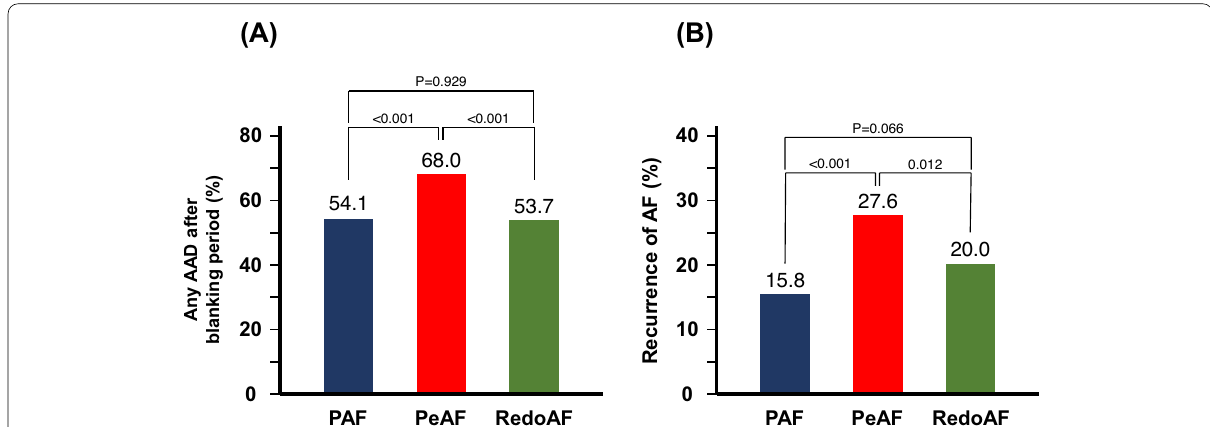
Fig. 2 Use of antiarrhythmic drug after blanking period and recurrence rate of AF at 1 year. Use of antiarrhythmic drugs after blanking period ( A ) and AF recurrence rate at 1 year ( B ) were more frequent in the patients with persistent AF compared to the ones with paroxysmal AF and redo AF. AAD, antiarrhythmic drug; AF, atrial fibrillation; PAF, paroxysmal AF; PeAF, persistent AF